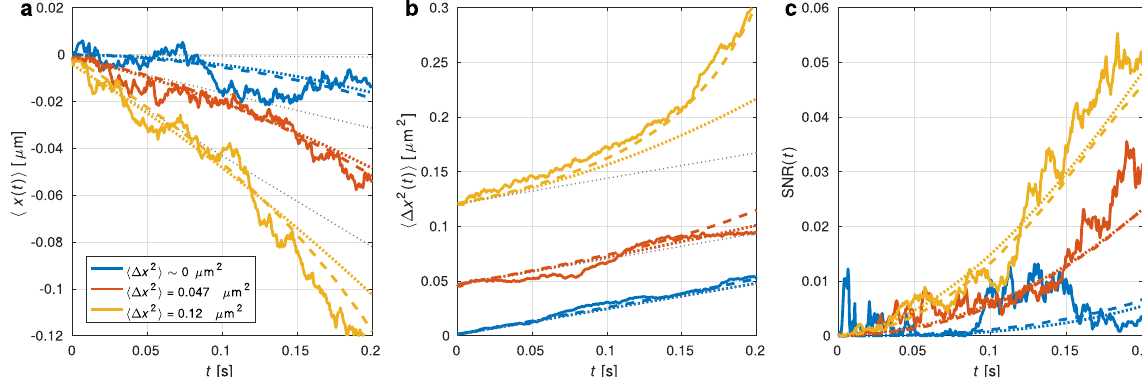
Figure 2. Experimental evidence of short-time stochastic non-linear dynamics. Panel ( a ) shows the mean particle position 〈 x ( t ) 〉 , panel ( b ) its variance 〈 Δ x 2 ( t ) 〉 and panel ( c ) the signal-to-noise ratio SNR( t ) = 〈 x ( t ) 〉 2 / 〈 Δ x 2 ( t ) 〉 developing in time from 〈 x (0) 〉 = 0 for three initial variances 〈 Δ x 2 (0) 〉 = 0 (blue), 0.047 (red), and 0.12 μ m 2 (yellow). Solid curves correspond to experimental data, dotted to equations (4, 5) in ( a ) and ( b ) or their ratio in (c) for κ obtained from the potential profile and corresponding hydrodynamic drag coefficient. Dotted grey lines show contribution of only linear time dependence terms taking place in equations (4) and (5). Dashed curves correspond to Monte Carlo simulations of the particle motion based on numerical solution of equation (1) with initial Gaussian